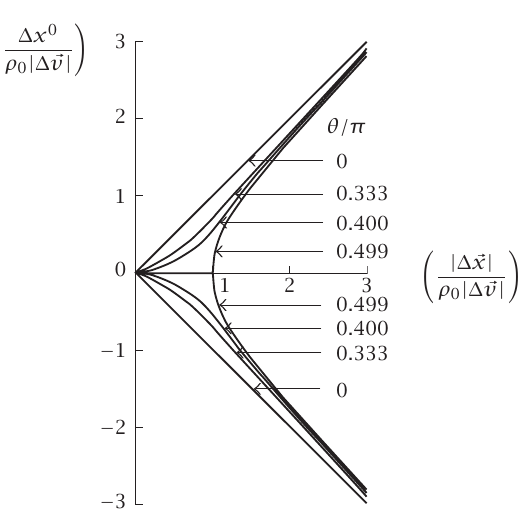
| ∆ (cid:11)v | ) as a 0